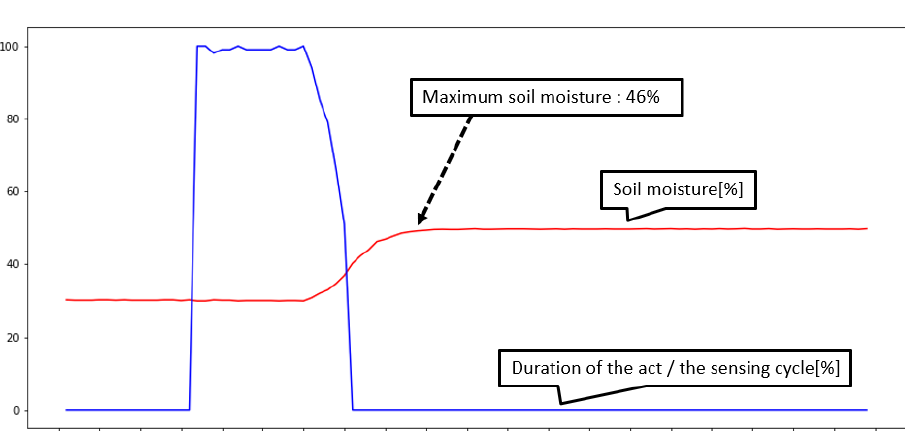
Figure 17. Current consumption of the heater.